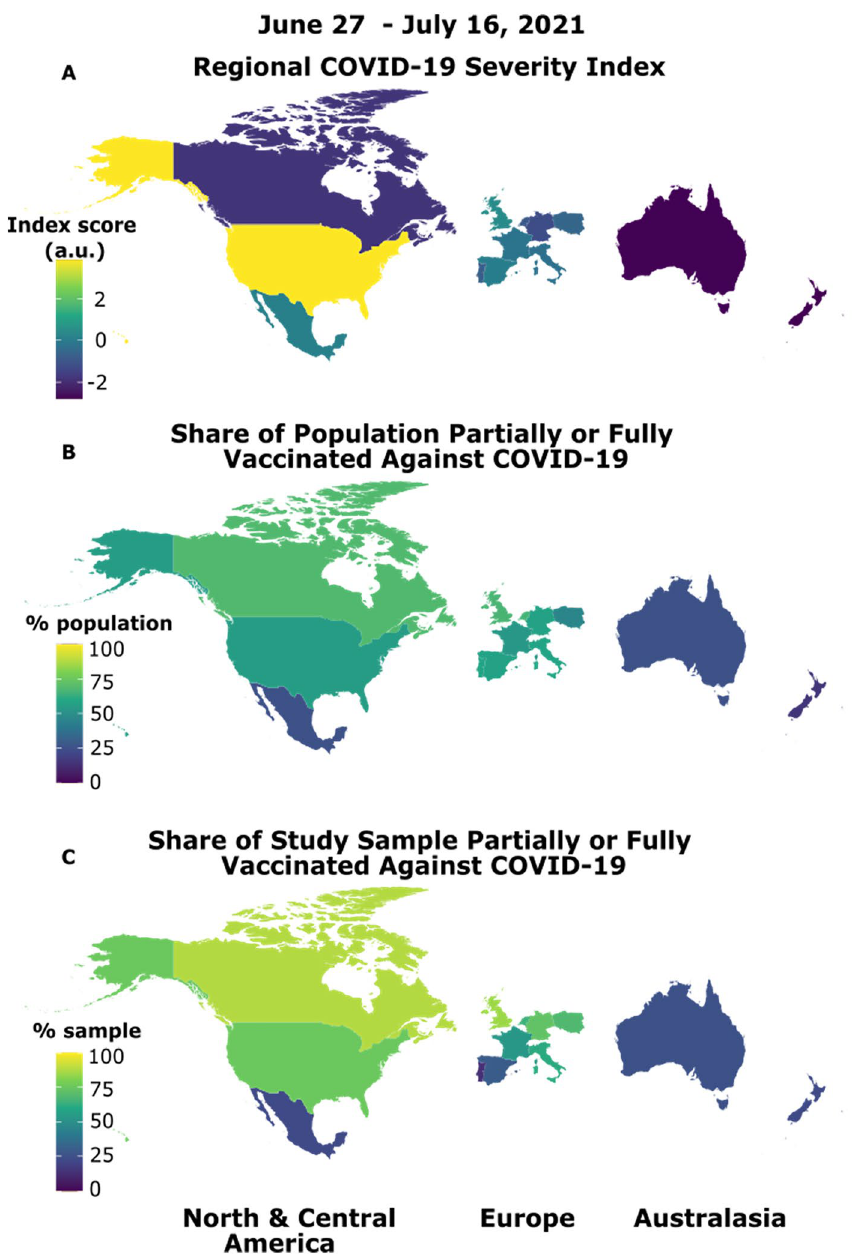
Figure 1. Pandemic and vaccine situations varied across our multinational sample at the time of testing. The R package "maps" was used to visualize regional differences on the COVID-19 Regional Severity Index and population and study sample vaccine situations (https:// cran.r- proje ct. org/ web/ packa ges/ maps/ index. html). ( A ) The Regional COVID-19 Severity Index is a nation’s component score (in arbitrary units, a.u.) from a principal component analysis of weekly COVID-19 cases/death rates, total cases/deaths since the first week of 2020, and population-adjusted total cases/deaths per 100,000. These nation-specific data were extracted from the European Centre for Disease Prevention and Control COVID-19 statistics 30 for each participant based on the week they completed the study. ( B ) The share of each nation’s population who were partially or fully vaccinated (i.e., one or more doses) against COVID-19, shown as the average percentage across our testing window; data were extracted from 31 . These data show lower proportions (15%) in countries only beginning vaccine roll-out (e.g., New Zealand) to almost 70% of the population in countries with earlier access to vaccines (e.g., United Kingdom, United States) and/or rapid uptake (e.g., Canada). ( C ) The share of participants from each country who were partially or fully vaccinated against COVID-19 (range 13% to 88%). Our sample was generally representative of population rates; the difference between sample rates ( C ) and population rates ( B ) for each country are plotted in Fig.